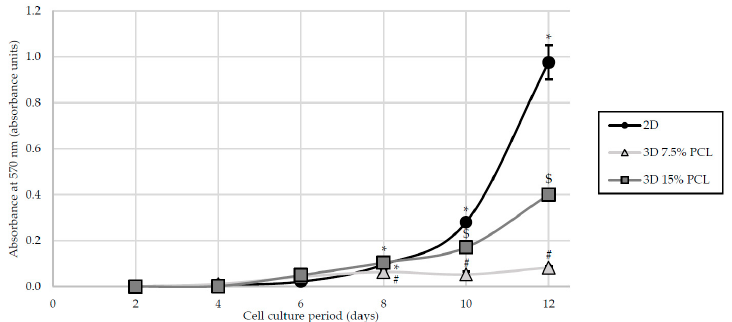
Figure 1. Cell proliferation analysis for MDA–MB–231 cells cultured on two-dimensional surfaces (2D) and on 7.5% and 15% PCL scaffolds (3D). (*), (#) and ($) symbols represent significant ( p < 0.05) differences between groups.